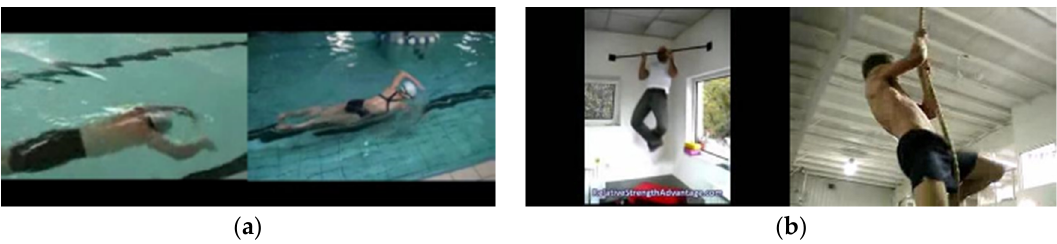
Figure 1. Examples of videos that have similar patterns in one pathway which will cause misclassification in the original two-stream network: ( a ) the “BreastStroke” versus the “FrontCrawl”, where they both have similar swimming pools as backgrounds though they are different swimming actions; ( b ) “PullUps” versus “RopeClimbing”, where they have similar motion patterns of raising the body in short snippets but different backgrounds.